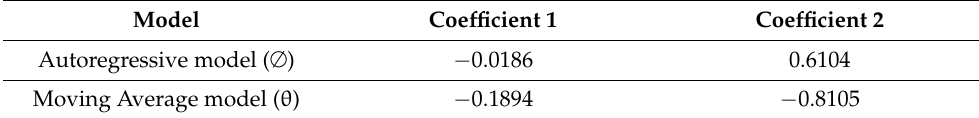
Table 5 . Estimated coefficients values.